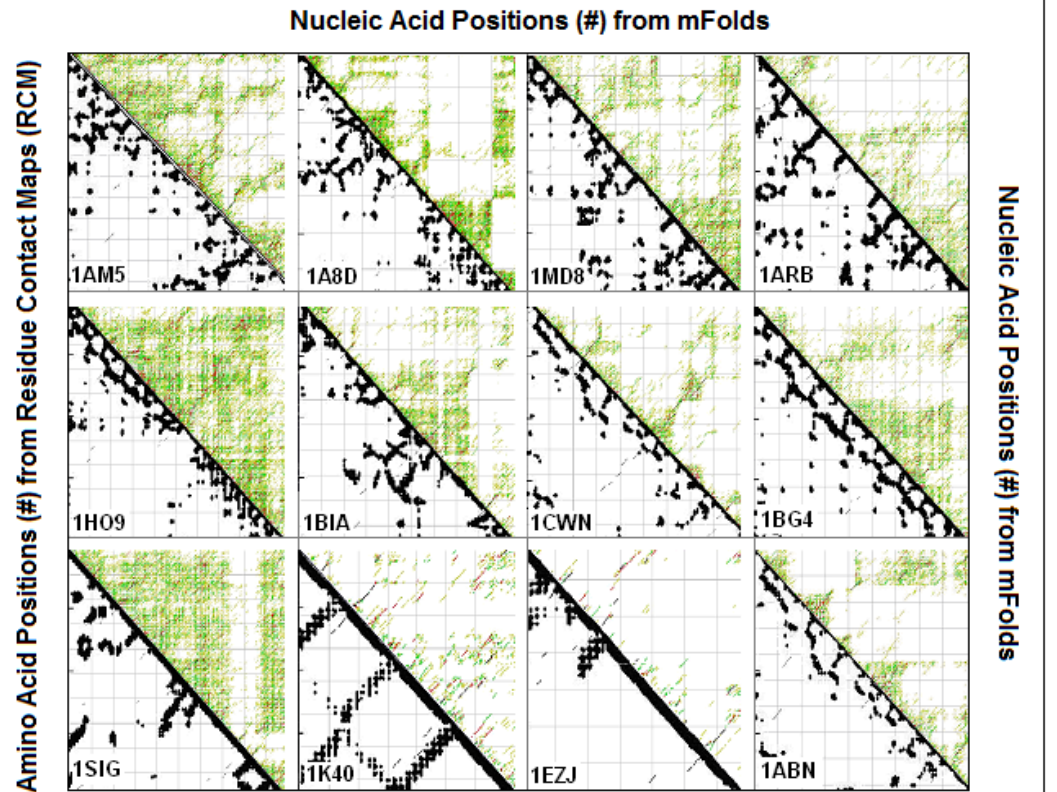
Figure 3. Comparison of 12 randomly selected protein and corresponding mRNA structures (modified from [47]). Residue contact maps (RCM) were obtained from the PBD files of the protein structures using the SeqX tool (left triangles). Energy dot plots (EDP) for the coding sequences were obtained using the mfold tool (right triangles). The two maps were aligned along a common left diagonal axis to facilitate visual comparison between the different possible representations. The black dots in the RCMs indicate amino acids that are within 6 Å of each other in the protein structure. The colored (grass-like) areas in the EDPs indicate the energetically mostly likely RNA interactions (color code in increasing order: yellow, green red, black). The coordinates indicate the number of amino acid and the corresponding nucleic acid